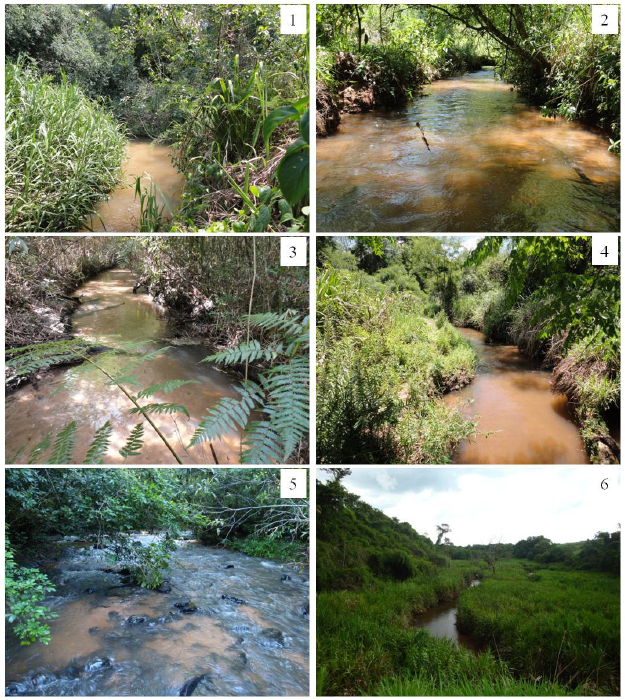
Examples of sampled localities in Rebio das Perobas, Ivaí and Piquiri River basins, Paraná, Brazil. 1) Concórdia Stream upstream; 2) Concórdia Stream downstream; 3) Saquarema River; 4) Mouro River; 5) Índios River upstream; 6) Índios River